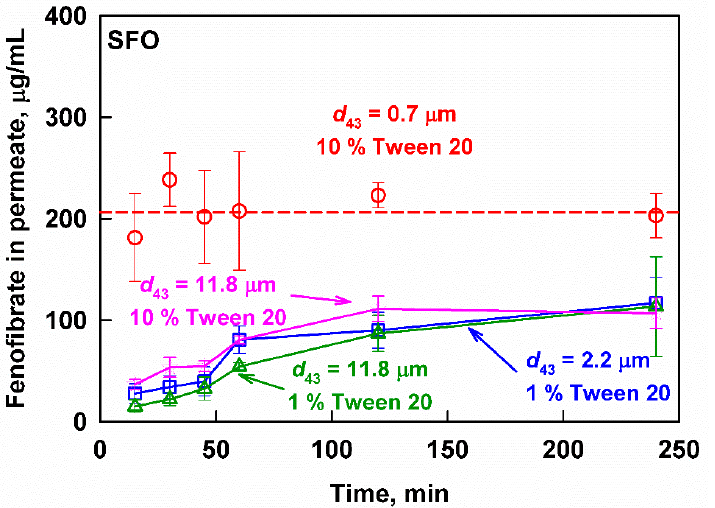
Figure 5. Fenofibrate measured in the aqueous phase after filtration as a function of the digestion time at simulated intestinal conditions of SFO emulsions with d 43 = 0.7 µm (10 wt% emulsifier, red circles), d 43 = 2.2 µm (1 wt% emulsifier, blue squares), d 43 = 11.8 µm (10 wt% emulsifier, pink stars) and d 43 = 11.8 µm (1 wt% emulsifier green triangles).